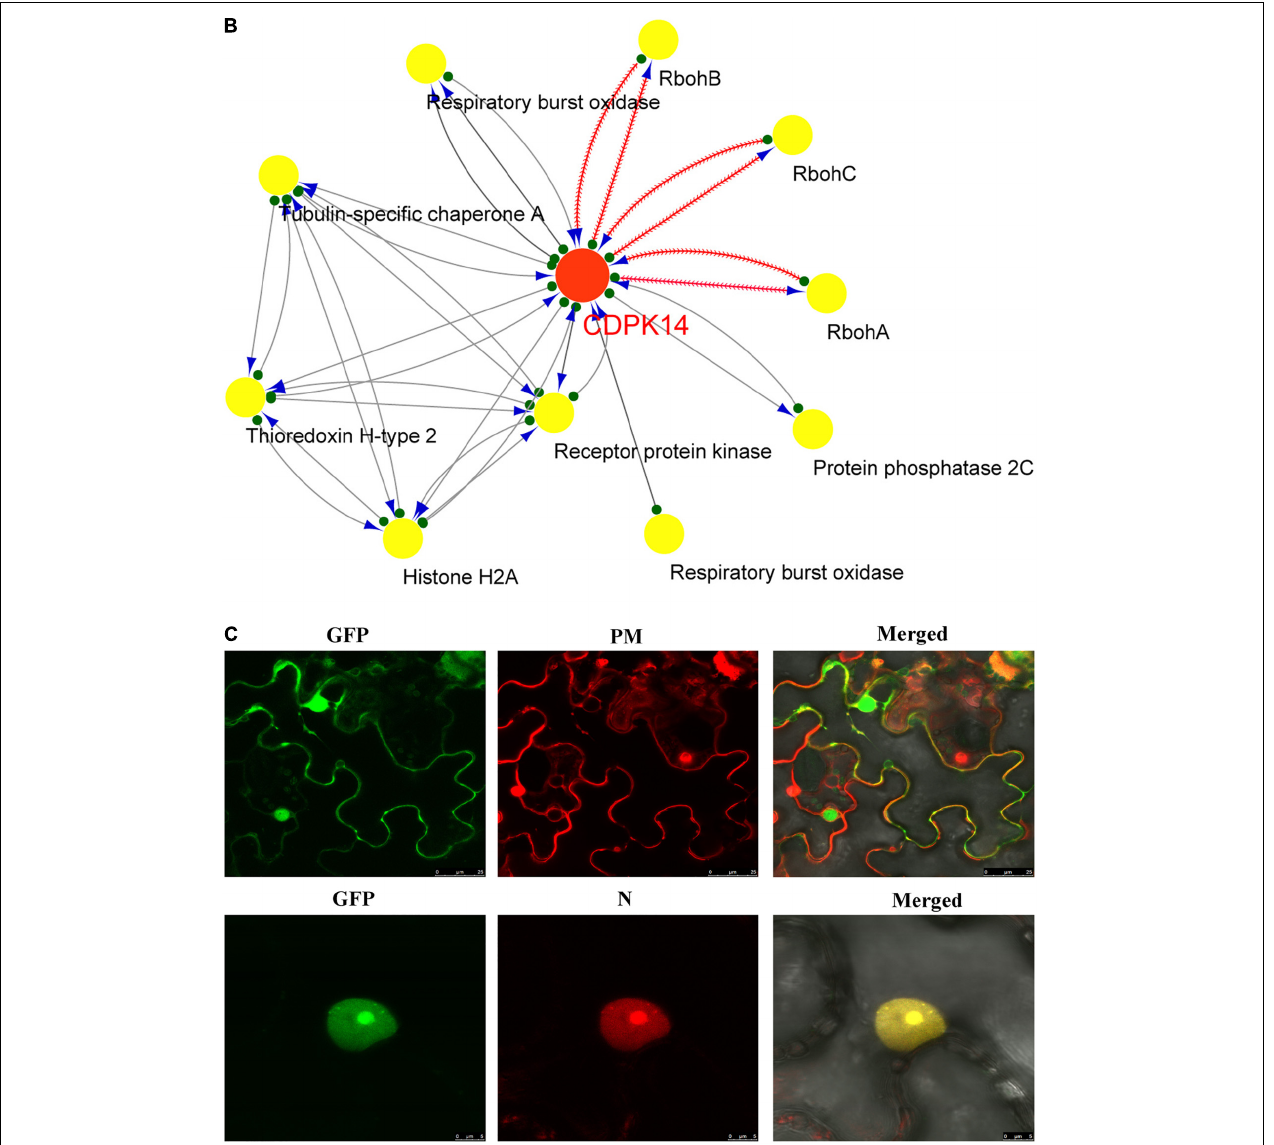
FIGURE 4 | Alignment of StCDPK14 and the predicted protein interaction network predicted for StCDPK14 and subcellular localization of StCDPK14-GFP. (A) Amino acid sequence alignment of StCDPK14 with AtCDPK29 (NP_974150.2), SlCDPK29 (XP_004238385), and OsCDPK19 (XP_015646656.1). Fully conserved resides are highlighted with a black background and 75% conserved residues by a gray background. (B) Protein interaction network of StCDPK14 and StRbohs in potato. Red node presents the input protein and yellow nodes are the predicted interactors. (C) Subcellular localization of StCDPK14-GFP fusion proteins in N. benthamiana leaf epidermal cells. The left panel represents GFP fluorescence, the middle represents membrane and nucleus marker, and the right is a merge of the two images. Bar = 25 µ m. (cid:70) Represent the core sequences and the conserved D-x-D residues in four EF-hand, (cid:80) represent the conserved sequences E-E-L-K, E-F-I-T, D-E-L, and E-F-A/V-A-M-M that is rich in Glu (E) after EF-hand domian,